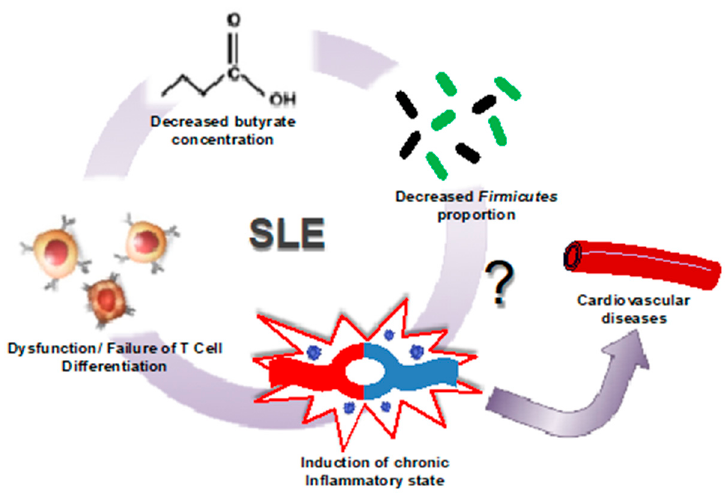
Figure 2. Microbiome shift in SLE induces cardiovascular risk. In patients with SLE, it has been observed that a decrease in the population of butyrate-producing Firmicutes leads to a decrease in butyrate production. This decreased production of butyrate leadsto the failure of T cells to properly differentiate in lupus patients, resulting in the induction of the chronic inflammatory state representative of this disease (modified from